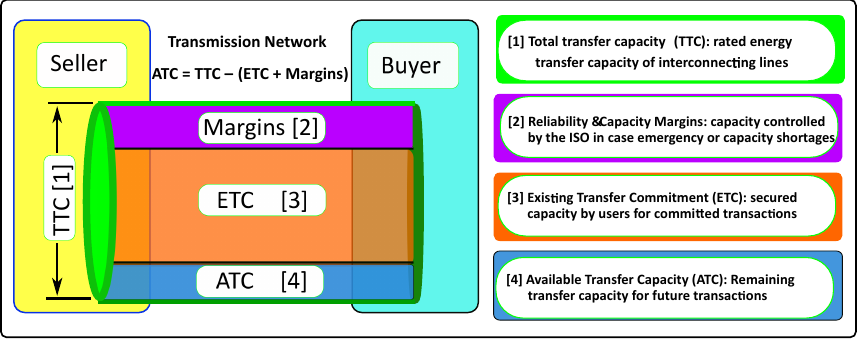
Figure 2. Illustration and basic estimation of